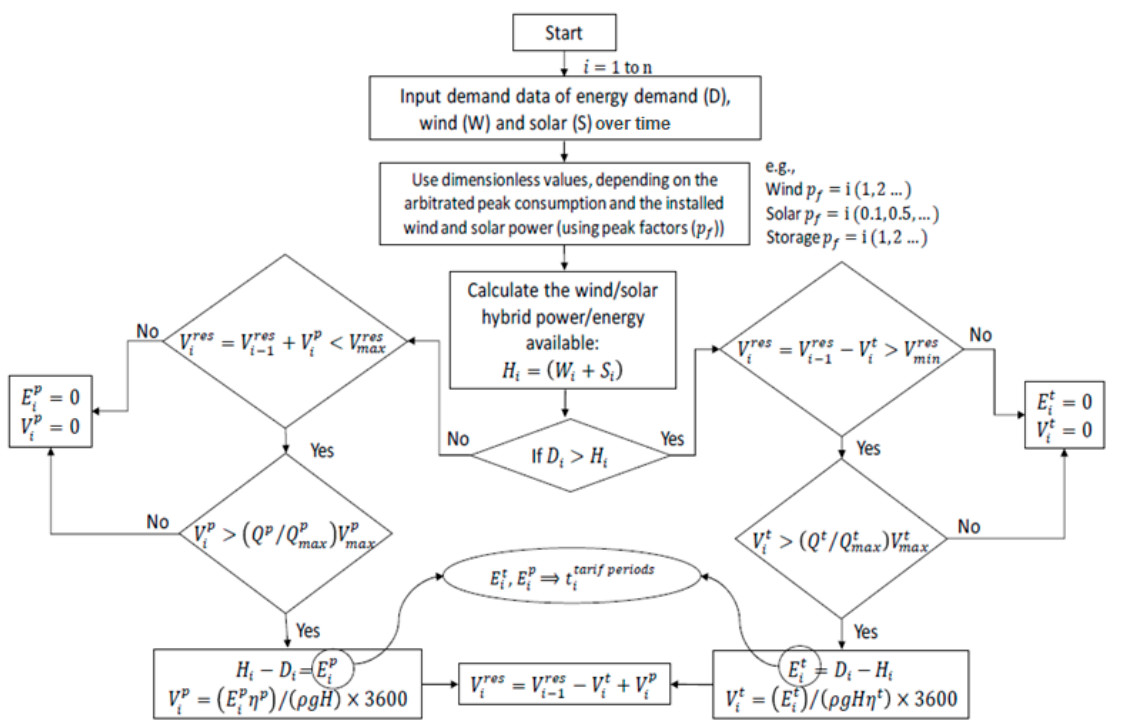
Figure 2. Example of an optimization algorithm between available renewable sources (for wind and solar energy).